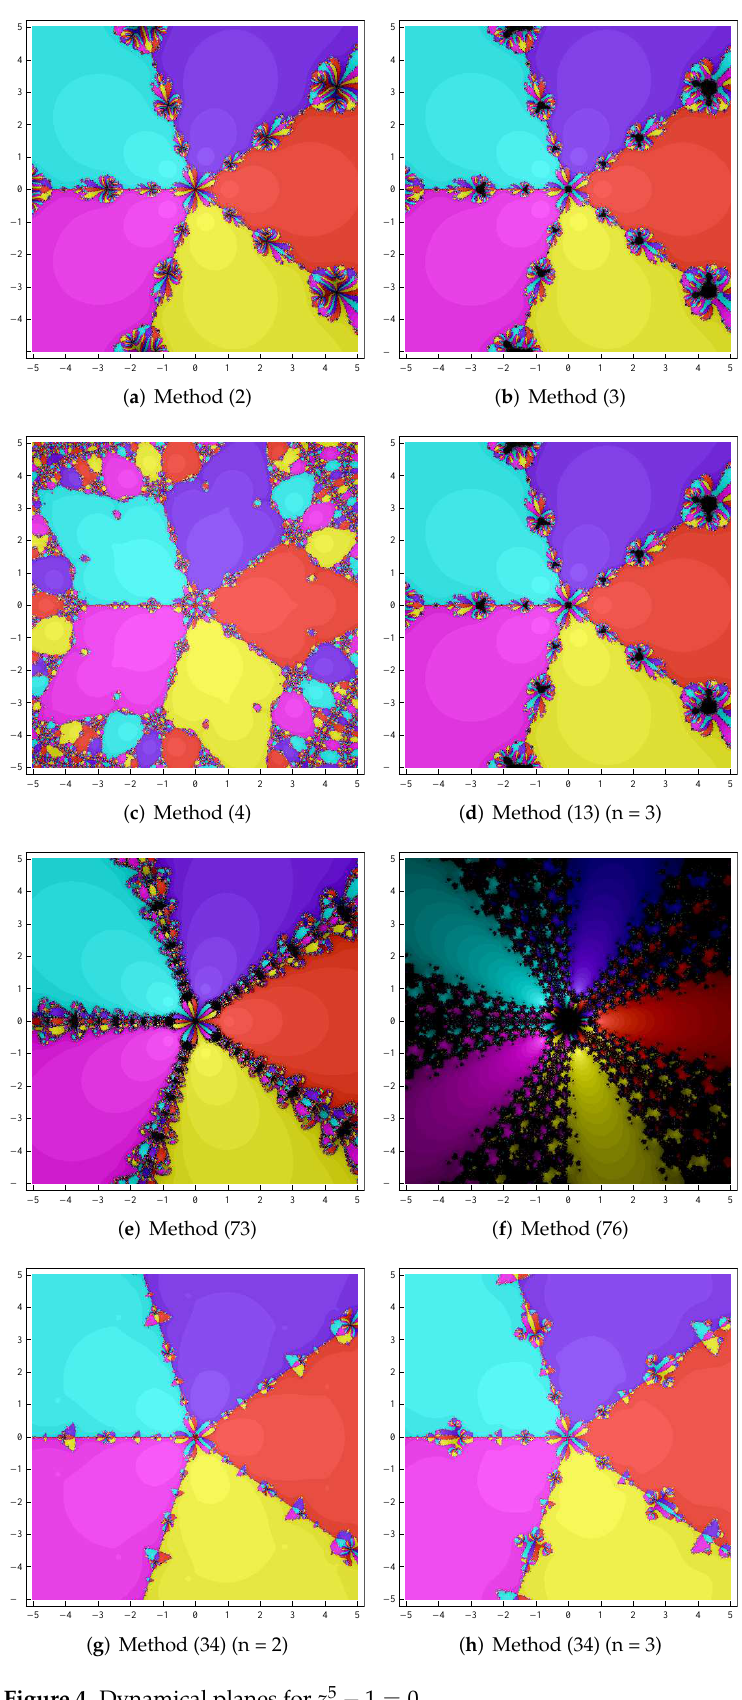
Figure 4. Dynamical planes for z 5 − 1 =